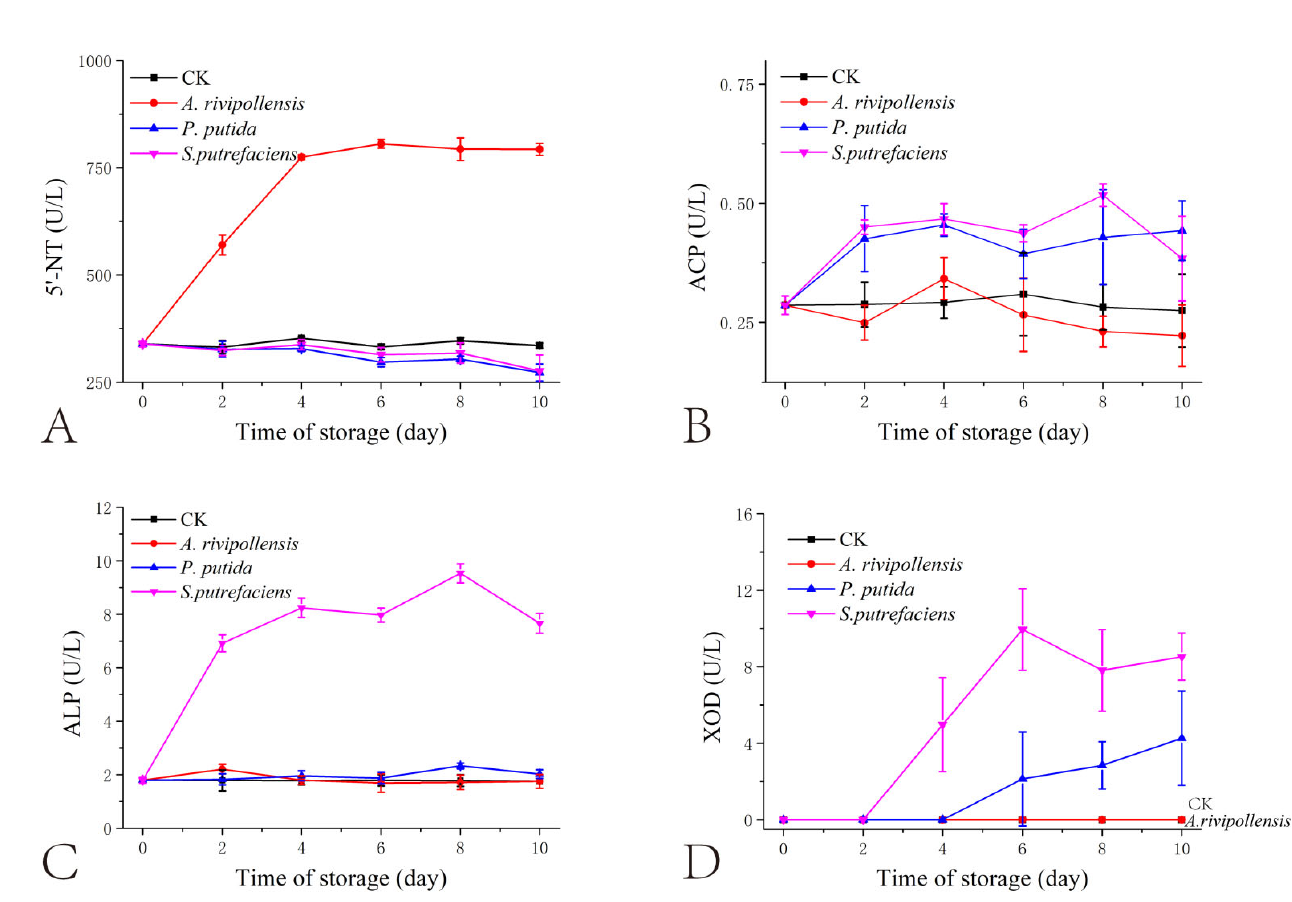
Figure 3. Changes in related enzyme activities of grass carp juice inoculated with different spoilage bacteria during 4 °C storage. ( A ) 5 ′‐ nucleotidase (5 ′‐ NT); ( B ) acid phosphatase (ACP); ( C ) alkaline phosphatase (ALP); ( D ) xanthine oxidase (XOD). CK: Not inoculated.